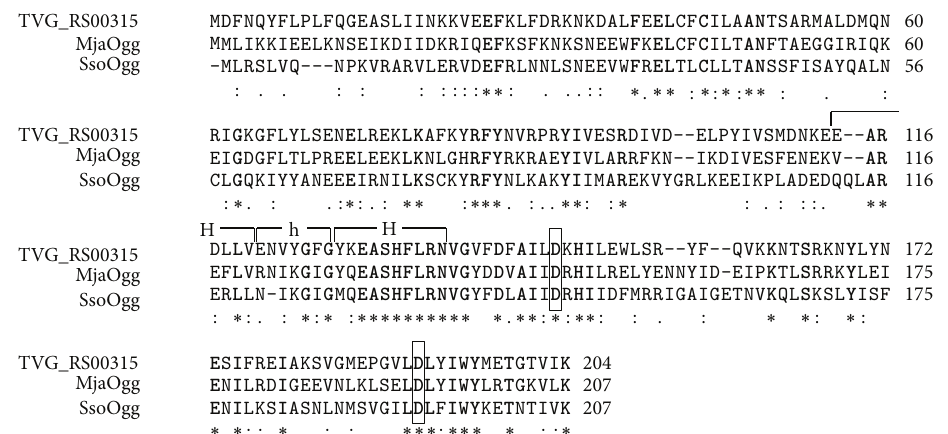
Figure 1: Amino acid sequence alignments of the TVG RS00315 protein (TvoOgg; WP 010916318.1) with 8-oxoguanine DNA glycosylase of Methanocaldococcus jannaschii (MjaOgg; Q58134) and 8-oxoguanine DNA glycosylase of Sulfolobus solfataricus (SsoOgg; WP 009992328). The amino acid residues in bold are conserved between the three proteins. “H” and “h” indicate alpha helices and hairpin structures, respectively. The catalytic residue of a conserved aspartate is boxed. Asterisks, colons, and dots indicate positions which have fully conserved, strongly similar, and weakly similar residues,